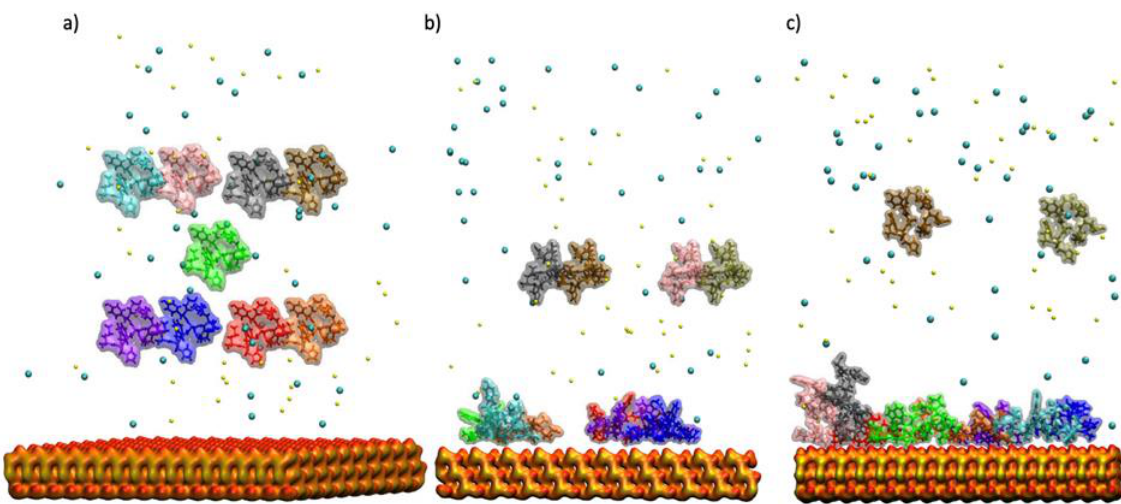
Figure 6. The simulation cell illustrating the GnRH-I starting positions above the model silica surface. ( a ) The initial 9 peptides; ( b ) the second simulation with 4 more peptides; ( c ) the third simulation with a further 2 peptides. GnRH-I proteins are displayed using a transparent surface overlapped on the VMD ‘liquorice’ representation, with each peptide given a different colour for ease of identification (see Table 1). Ions are shown as VdW spheres, Na+ ions are yellow while Cl – ions are blue. The silica slab is represented by a surface with red oxygen and yellow silicon atoms. The water is not shown for clarity.